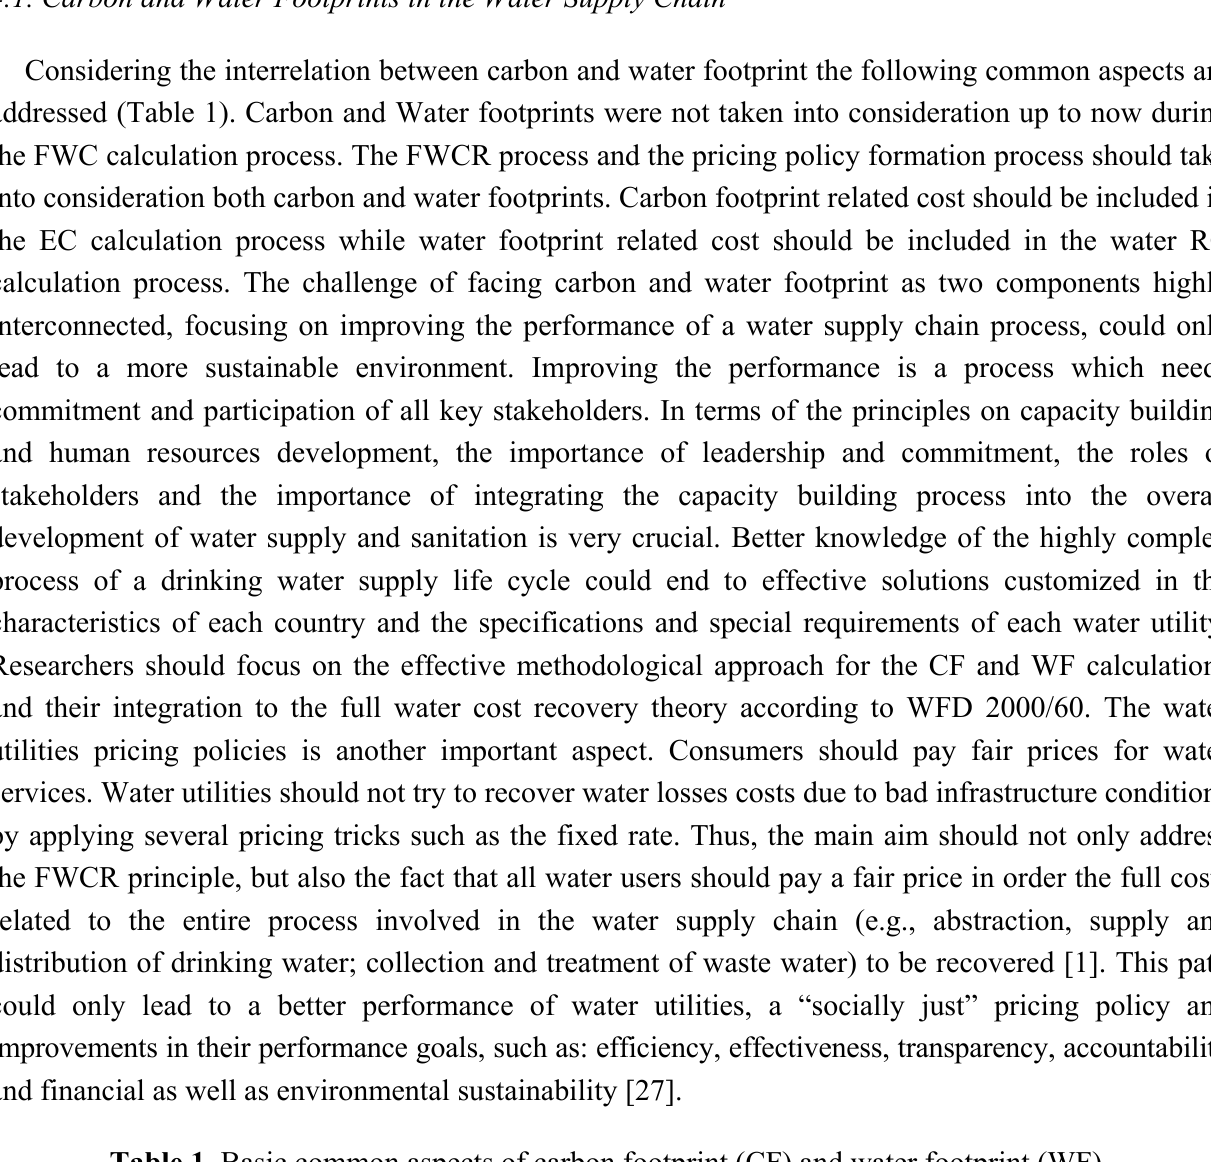
Table 1. Basic common aspects of carbon footprint (CF) and water footprint